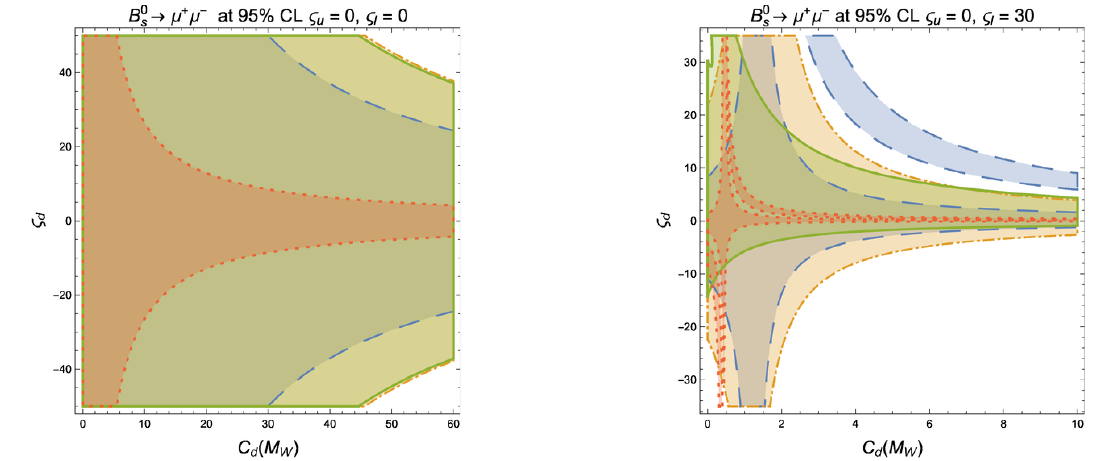
Figure 3. B 0 ! (cid:22) + (cid:22) (cid:0) constraints on C d ( M W ) and & d , in the CP-conserving limit, for (cid:21) 3 = (cid:21) 7 = 1, s c ~ (cid:11) = 0 : 95 and & u = 0, with & l = 0 (left) and & l = 30 (right). The coloured areas show the allowed regions (95% CL) for di(cid:11)erent mass con(cid:12)gurations de(cid:12)ned in eq. (7.3): A (red, dotted), B (green, solid line), C (blue, dashed) and D (orange,